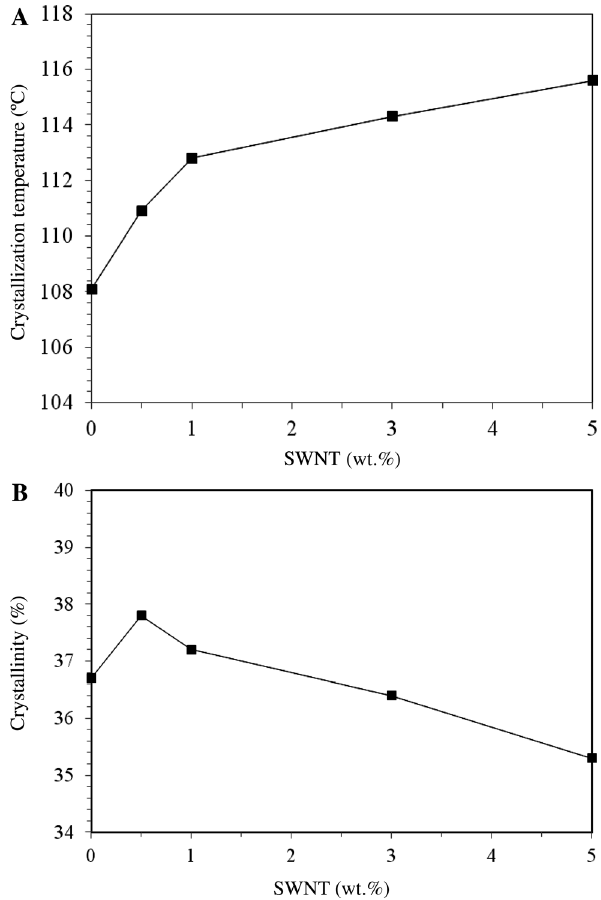
) and (B) crystallinity ( X c